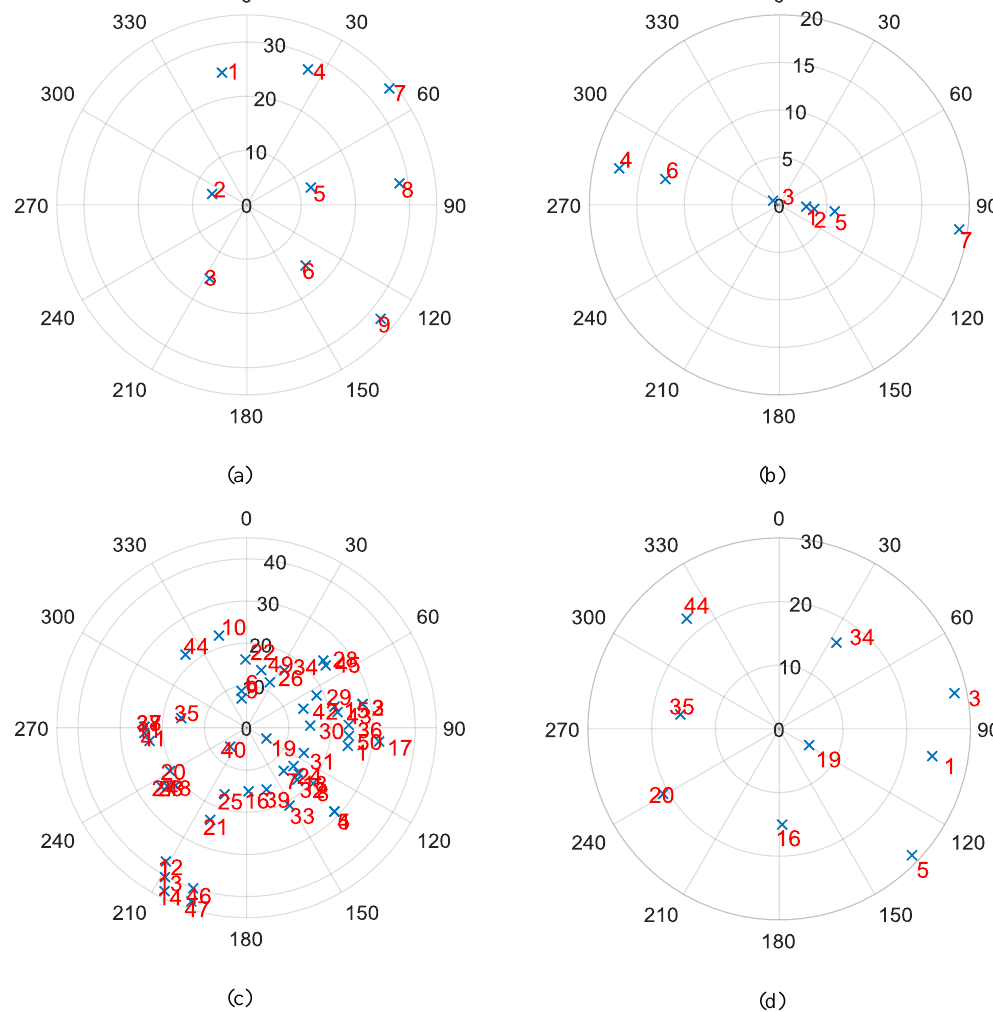
Figure 3. Image direction angles in polar coordinates. (a) Image direction angles of JL1 dataset. (b) Image direction angles of GF2 dataset. (c) Image direction angles of WV3 dataset. (d) Image direction angles of the images selected from WV3 dataset